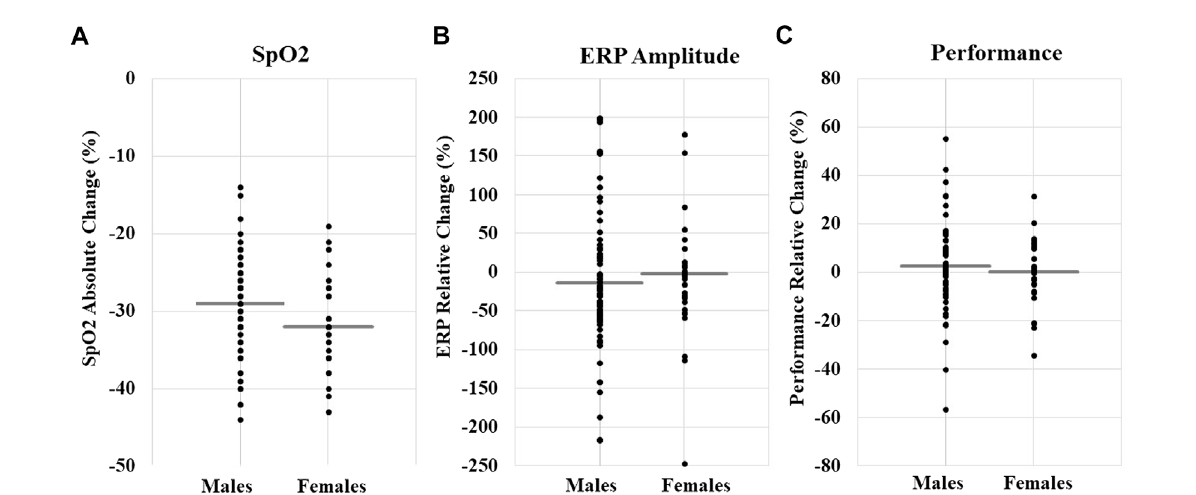
FIGURE 2 (A) SpO 2 absolutechange(%)bysex;totalN M ± SD, − 30.15±6.17. (B) ERPrelativechange(%)bysex;totalN M ± SD, − 11.92±87.82. (C) Cognitive performance relative change (%); total N M ± SD, 2.03 ± 15.62. Each data point represents an individual participant ’ schange value, and the gray line is the mean for each sex. The fi gure is a visualization of data and does not represent the results of a statistical